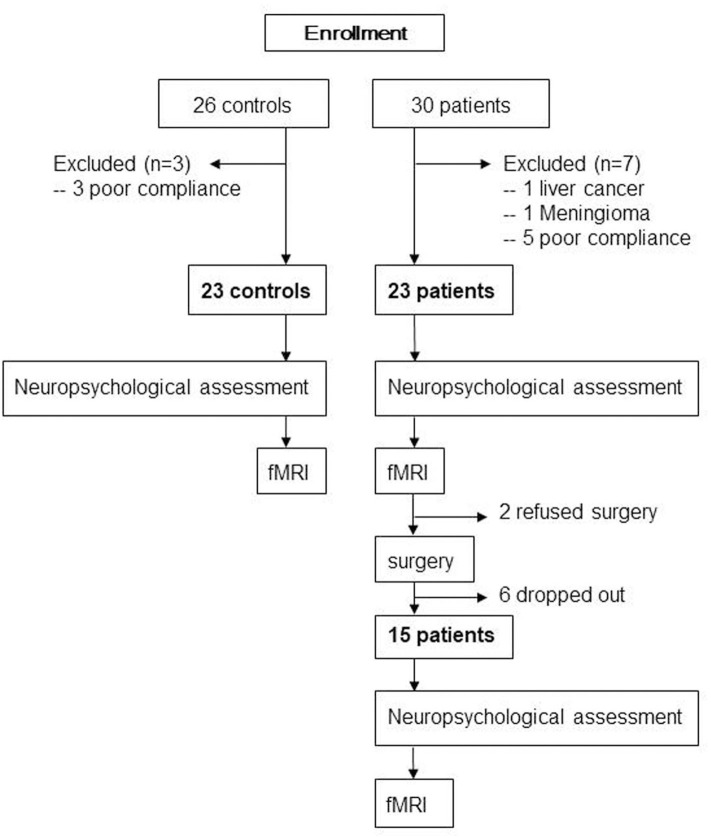
Flow diagram showing selection of eligible participants and the enrollment process.